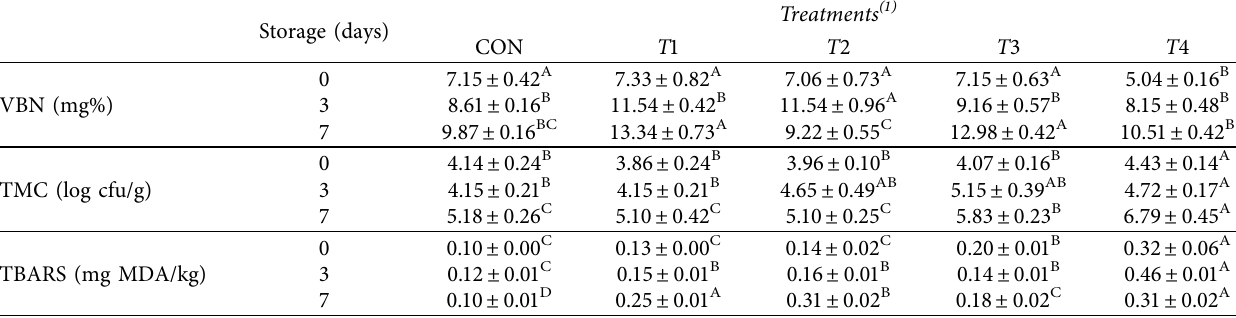
Table 6: Volatile basic nitrogen (VBN), total microbial count (TMC), and 2-thiobarbituric acid reactive substances (TBARS) of the hybrid beef patty with shiitake mushroom ( Lentinus edodes